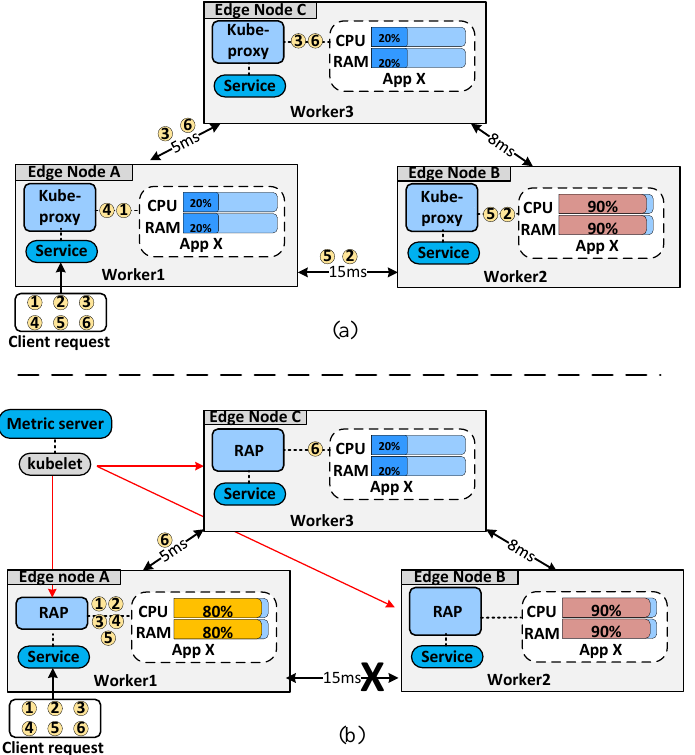
Figure 3. Load-balancing algorithms of ( a ) userspace and ( b ) RAP in K8s-based edge computing